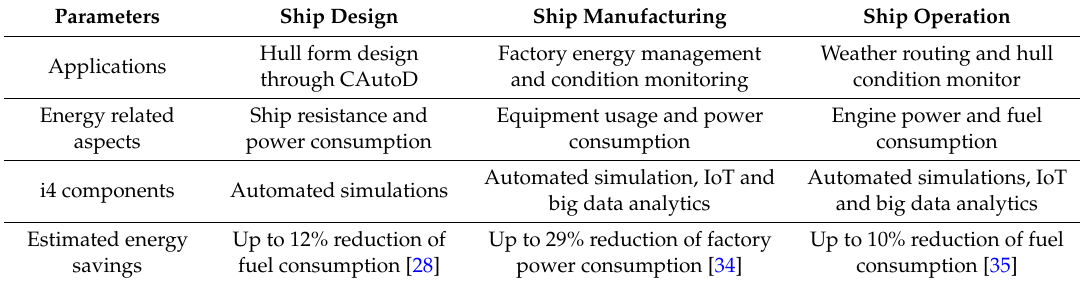
Table 2. Applications of i4 technologies during the ship lifecycle and estimated energy